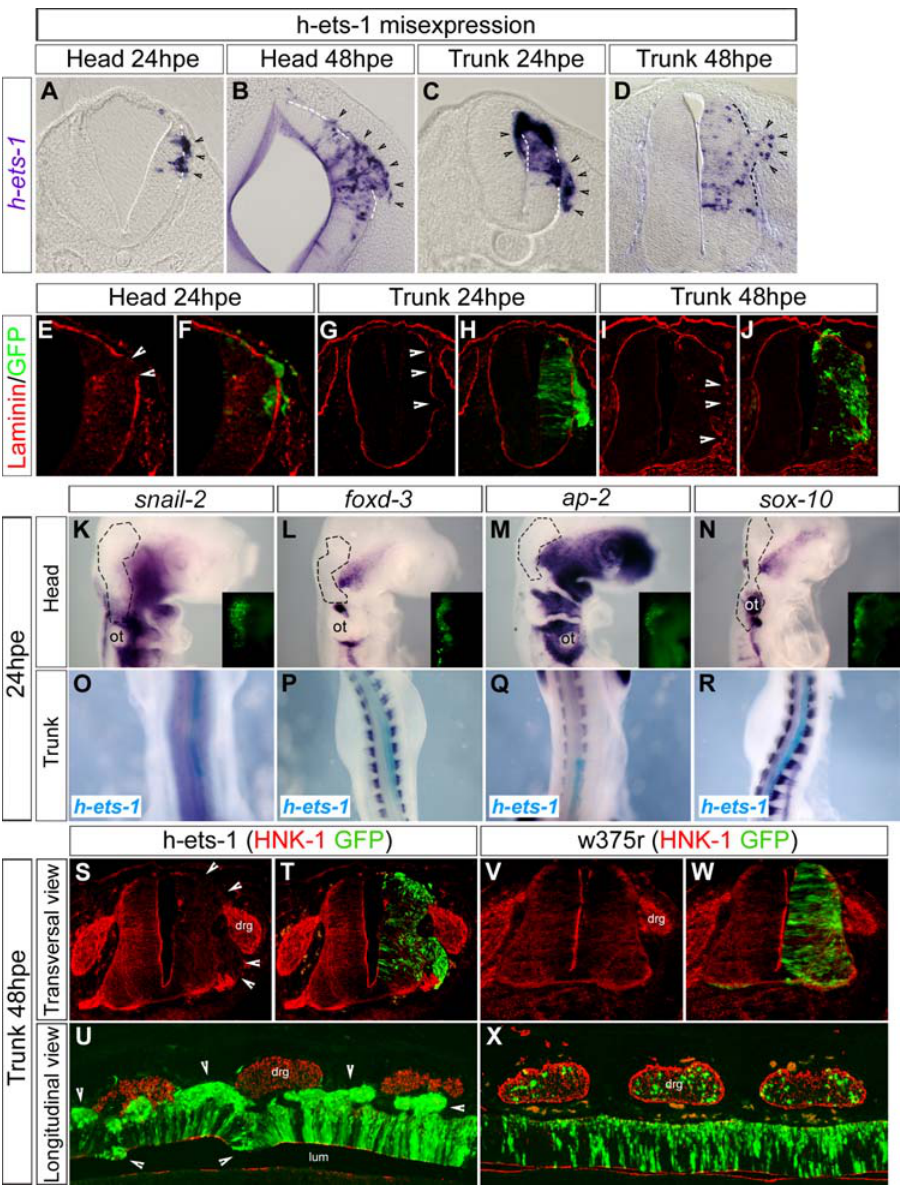
Figure 6. Ets-1 Misexpression Triggers Ectopic Delamination without Inducing Neural Crest Fate. (A–J) Analysis of the effects of h-ets-1 misexpression in intermediate to ventral neural tube at 24hpe (A, C, E–H) and 48hpe (B, D, I–J); at head (A–B, E–F) and trunk (C–D, G–J) levels. (A–D) Vibratome sections (30 m m) of whole mount in situ hybridization using h-ets-1 probe. At 24hpe, misexpression of h-ets-1 leads to ectopic delaminations towards basal or luminal sides (A, C, arrow heads; dotted lines indicate the neural tube limit). At 48hpe, the phenomena is stronger, involving more cells leaving the neural tube in both head (B) and trunk (D) as compact bulges of cells. (E–J) Transversal cryosections (10 m m) labeled with anti-Laminin antibody. Electroporated cells degrade the basal lamina (arrow heads) before invading the ECM. (K–X) Analysis of NCC fate in ectopic delaminating cells. (K–R) Whole mount in situ hybridization with snail-2 (K–O, dark blue), foxd-3 (L–P, dark blue), ap-2 (M–Q, dark blue), sox-10 (N–R, dark blue) and h-ets-1 (O, P, Q, R, light blue) probes. Dotted lines in (K), (L), (M), (N) indicate the transfected area as defined by GFP expression (insets in K, L, M, N). (S–X) Immunofluorescence labeling with anti-HNK-1 antibody on transversal (S–T, V–W) and longitudinal (U, X) cryosections (10 m m). At 24hpe, misexpression of h-ets-1 in head or trunk does not ectopically activate snail-2 , foxd-3 , ap-2 or sox-10 (K–R). Furthermore, at 48hpe ectopic cells (including cells emerging from the dorsal part of the neural tube) never express HNK-1 (S–U, arrow heads). Misexpression of w375r has no effect (V–X). drg, dorsal root ganglia; lum, lumen; ot, otic